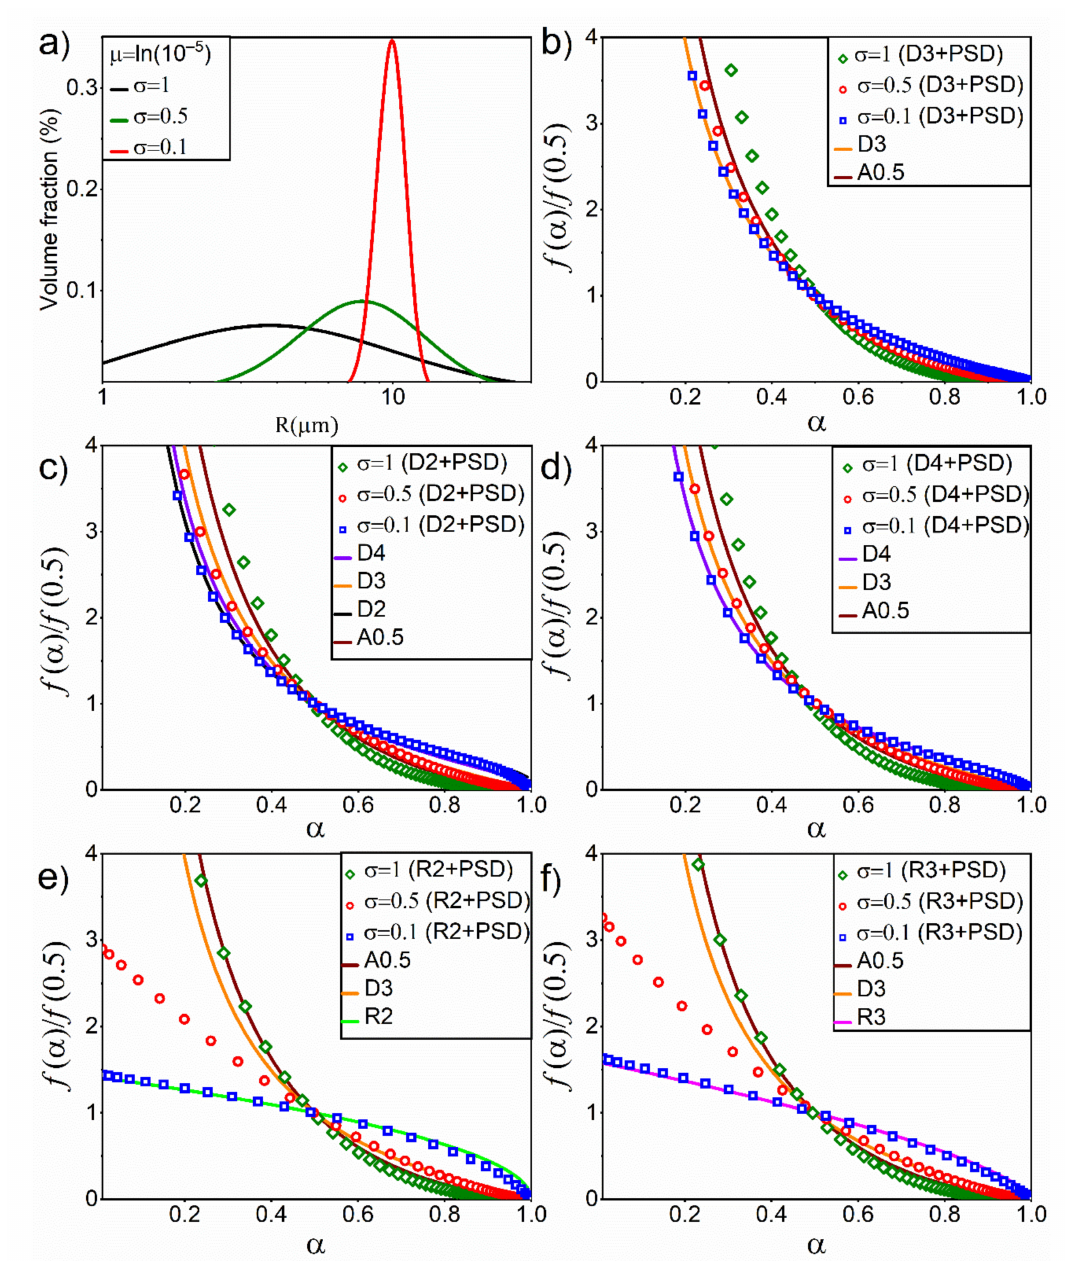
Figure 5. Modification of ideal kinetic models when PSD is taken into consideration. ( a ) Different PSD used. ( b ) D3, ( c ) D2, ( d ) D4, ( e ) R2 and ( f )